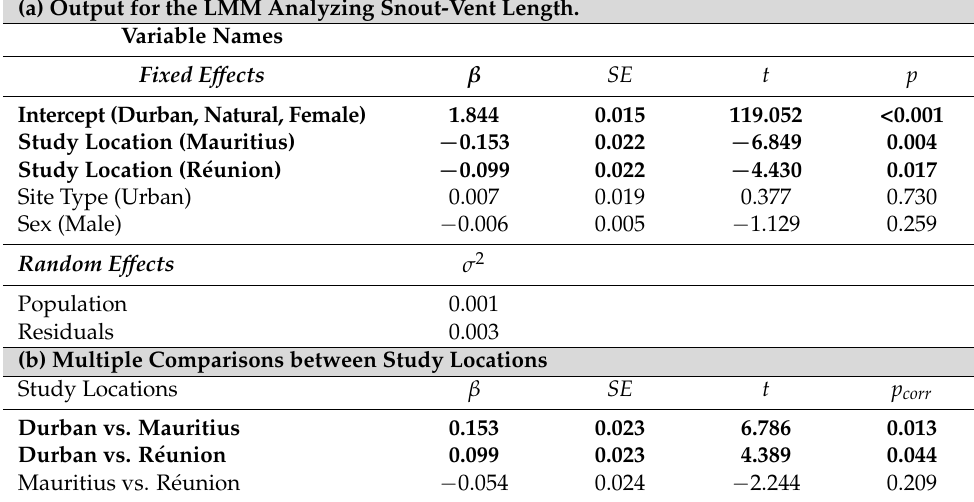
Table 3. ( a ) Outcome of the LMM examining differences in guttural toad ( Sclerophrys gutturalis ) SVL (mm). All coefficient estimates are representative of log 10 -transformed morphological measures. Since the interaction between study location and site type was not significant, it was removed and the models were re-run. Coefficient estimates ( β ) of fixed effects are presented with their corresponding standard errors ( SE ), variance estimates ( σ 2 ) are supplied for residuals and random effects, and all significant values ( p < 0.05) are bolded. Reference levels for each categorical variable are supplied in brackets following the variable name. ( b ) Post hoc multiple comparisons of SVL between all study locations; in this case, p -values ( p corr ) were corrected using an “ mvt ” adjustment [63].